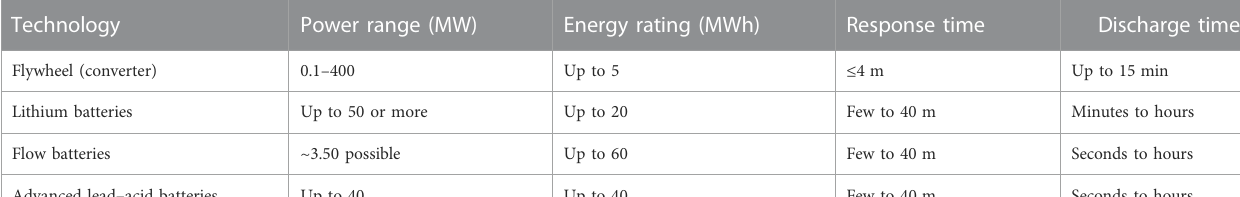
TABLE 3 Examples of the electrochemical energy storage suitable for fast response services.